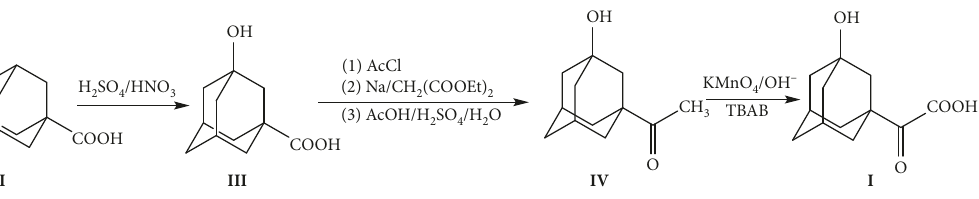
Figure 4: A convenient approach to prepare I